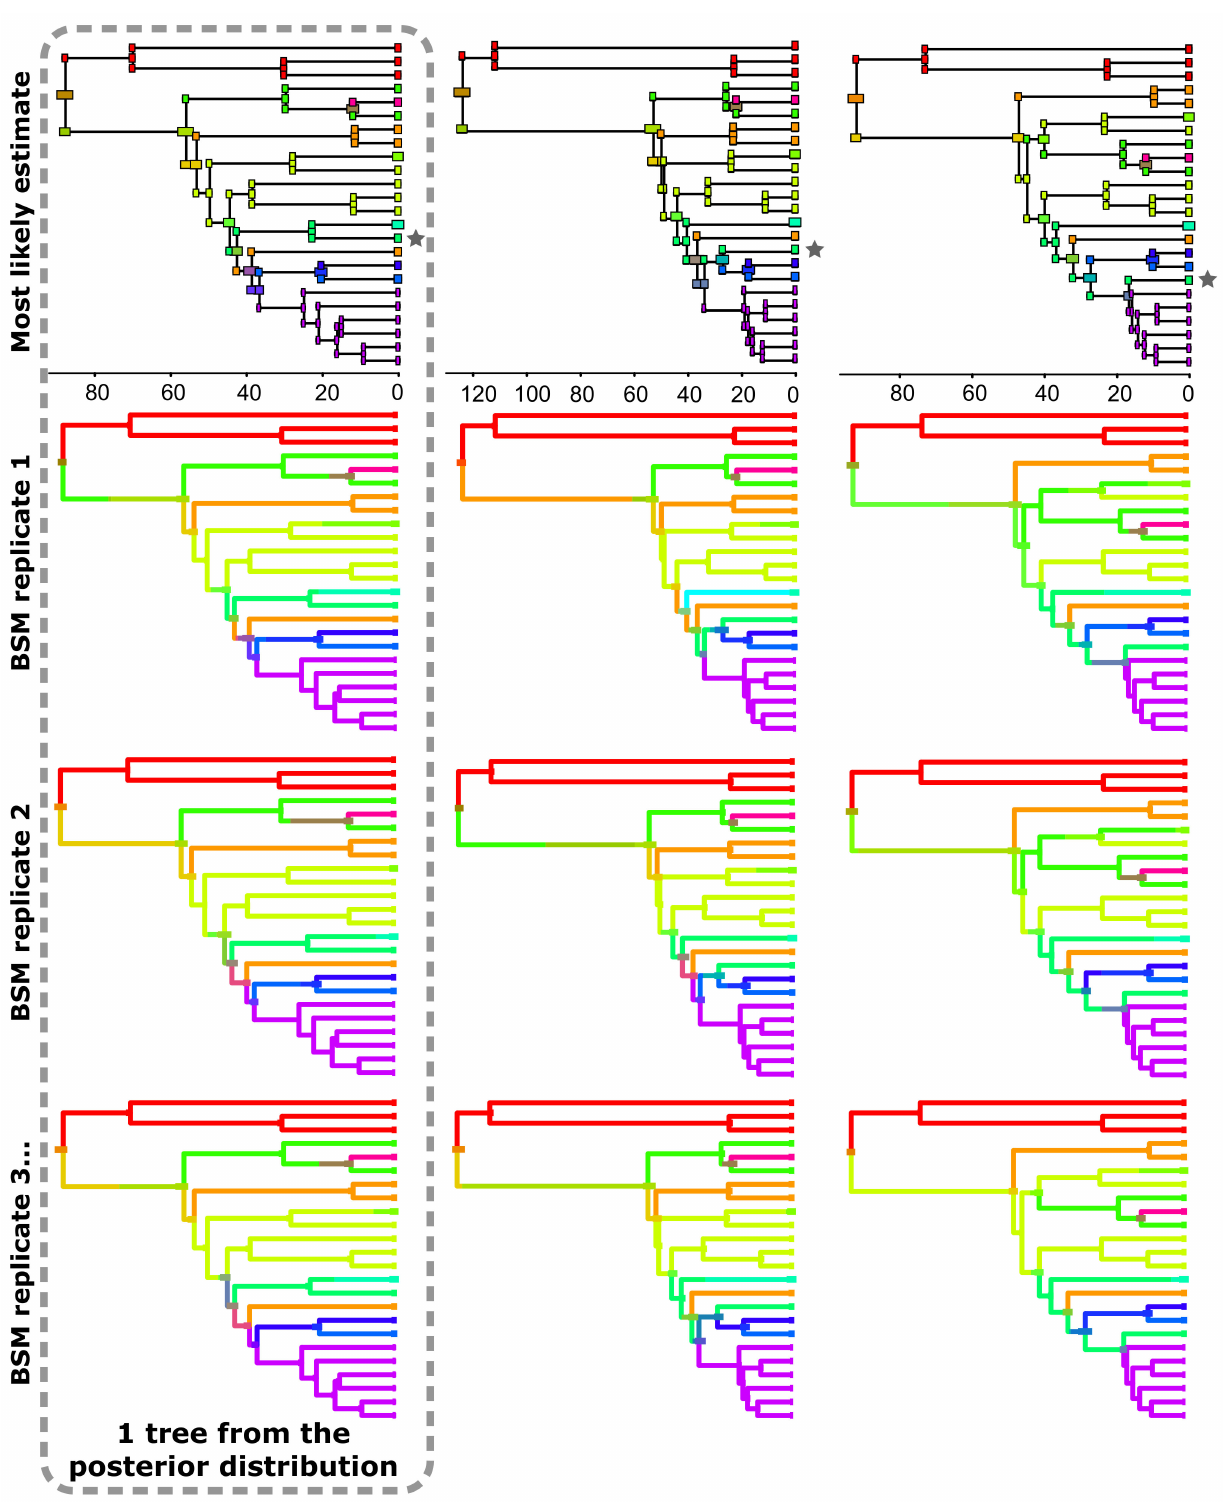
Figure 1. Biogeographic stochastic maps are insufficient to account for uncertainty in ancestral range estimates. Each column represents a single tree from the posterior distribution of the Bayesian analysis of our dataset, with the most likely estimated states in the top row and different stochastic maps in the bottom rows. While estimates in each stochastic map are different, the most remarkable differences are found among trees with different topologies. Note the tip marked with a grey star, which is a rogue taxon ( Sicarius andinus ). As it shifts its position across the different trees of the stationary phase of the chain, it leads to substantially different ancestral range estimates in each